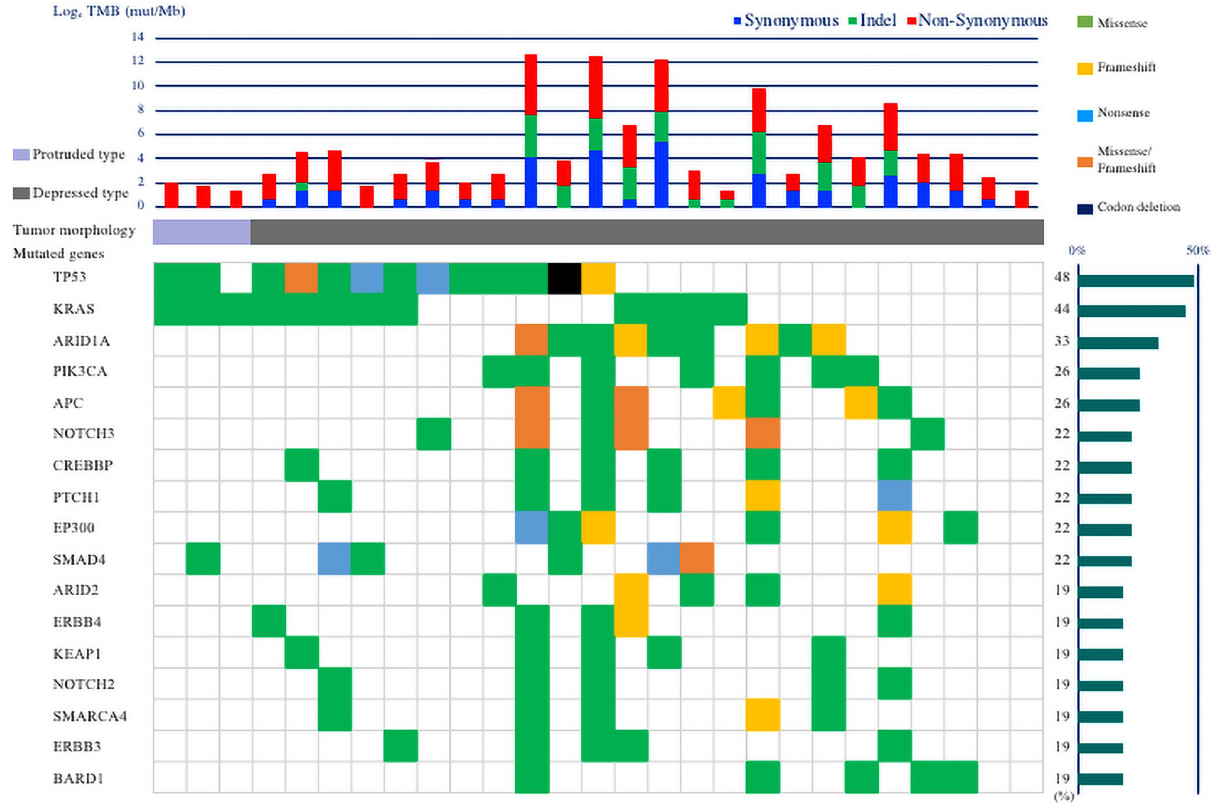
Fig 1. Genomic landscapes of 27 small-bowel cancers. Upper panel : Number of somatic mutations per sample. Blue bars indicate the number of synonymous mutations, green bars indicate the number of insertions/deletions (indels), and red bars indicate the number of non-synonymous mutations. Middle panel : Morphology of lesions. Light purple bars indicate protruded type tumor morphology (defined as Type 1 morphology) and gray bars indicate depressed type tumor morphology (defined as Type 2 and Type 3 morphology). Lower panel : Mutation pattern of 17 mutated genes with a frequency > 15% from 27 small-bowel cancers. Mutated genes are shown. Green cells indicate missense mutations, yellow cells indicate frameshift mutations, light blue cells indicate nonsense mutations, orange cells indicate missense/frameshift mutations, and black cells indicate codon deletions. The bar graph on the right indicates the frequency of each mutated gene of small-bowel cancers.